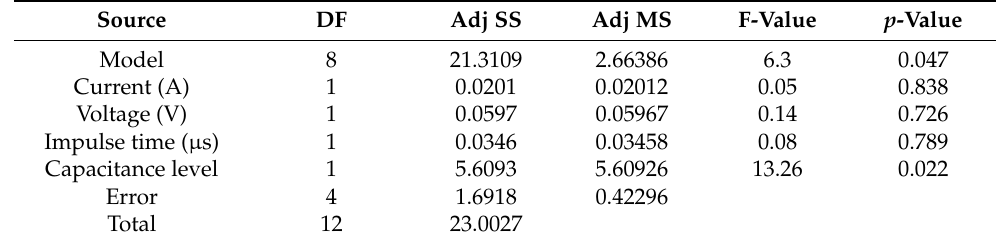
Table 8. Statistical analysis (ANOVA) of the influence of machining parameters on material removal rate.